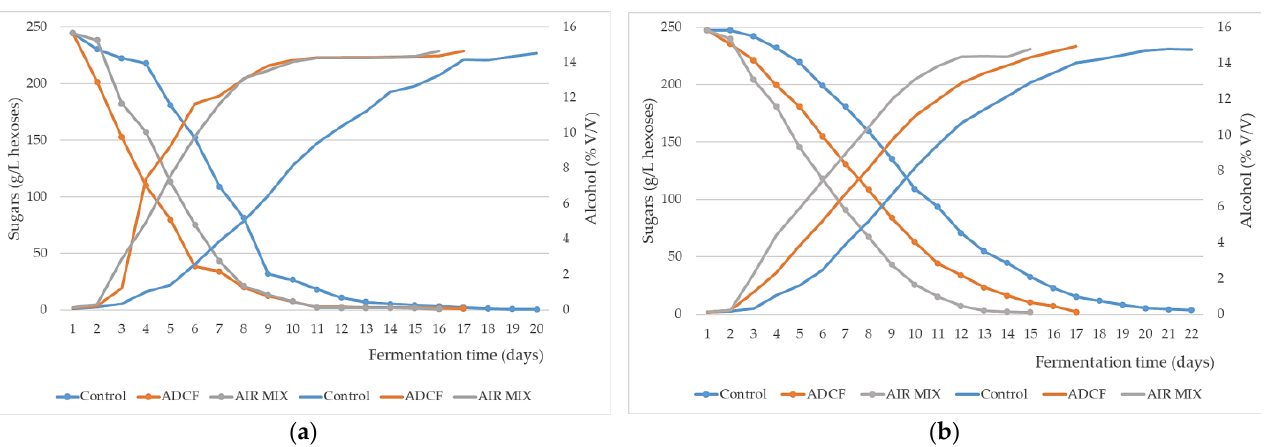
Figure 1. Sugars (lines with solid dots) and alcohol content are in the Y-axes and fermentation time in the X-axis. ( a ) Fermentation kinetics 2020; ( b ) fermentation kinetics 2021.